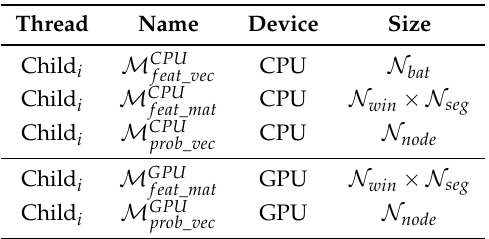
Table 1. Summarization of the allocated run-time memories at CPU and GPU of the baseline multichannel acoustic score computation.